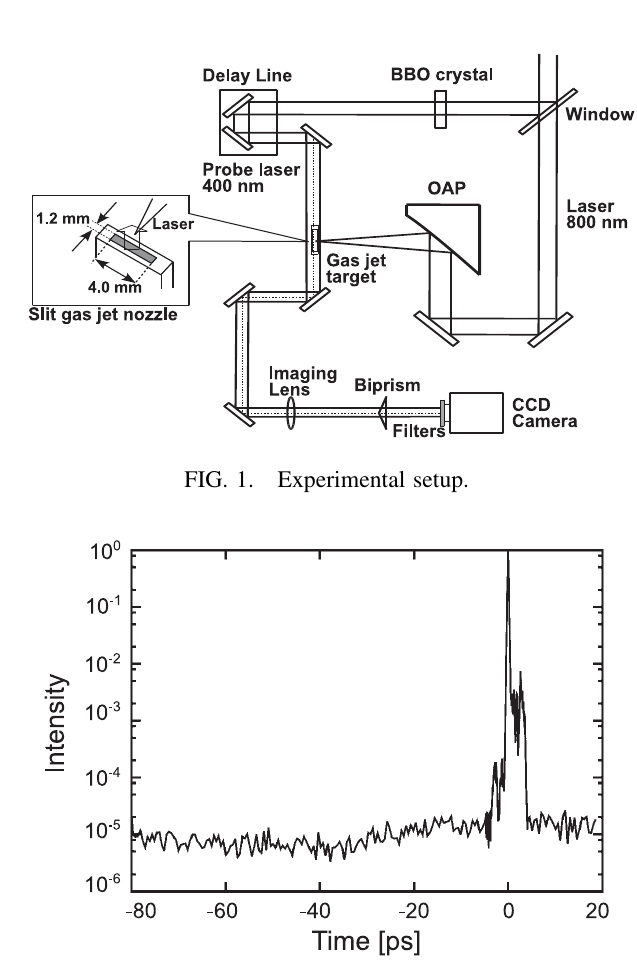
FIG. 2. Third-order autocorrelation trace of the driving laser. The ASE pedestal level is around 10 (cid:4) 5 . The pulse duration of the main pulse is 0.3